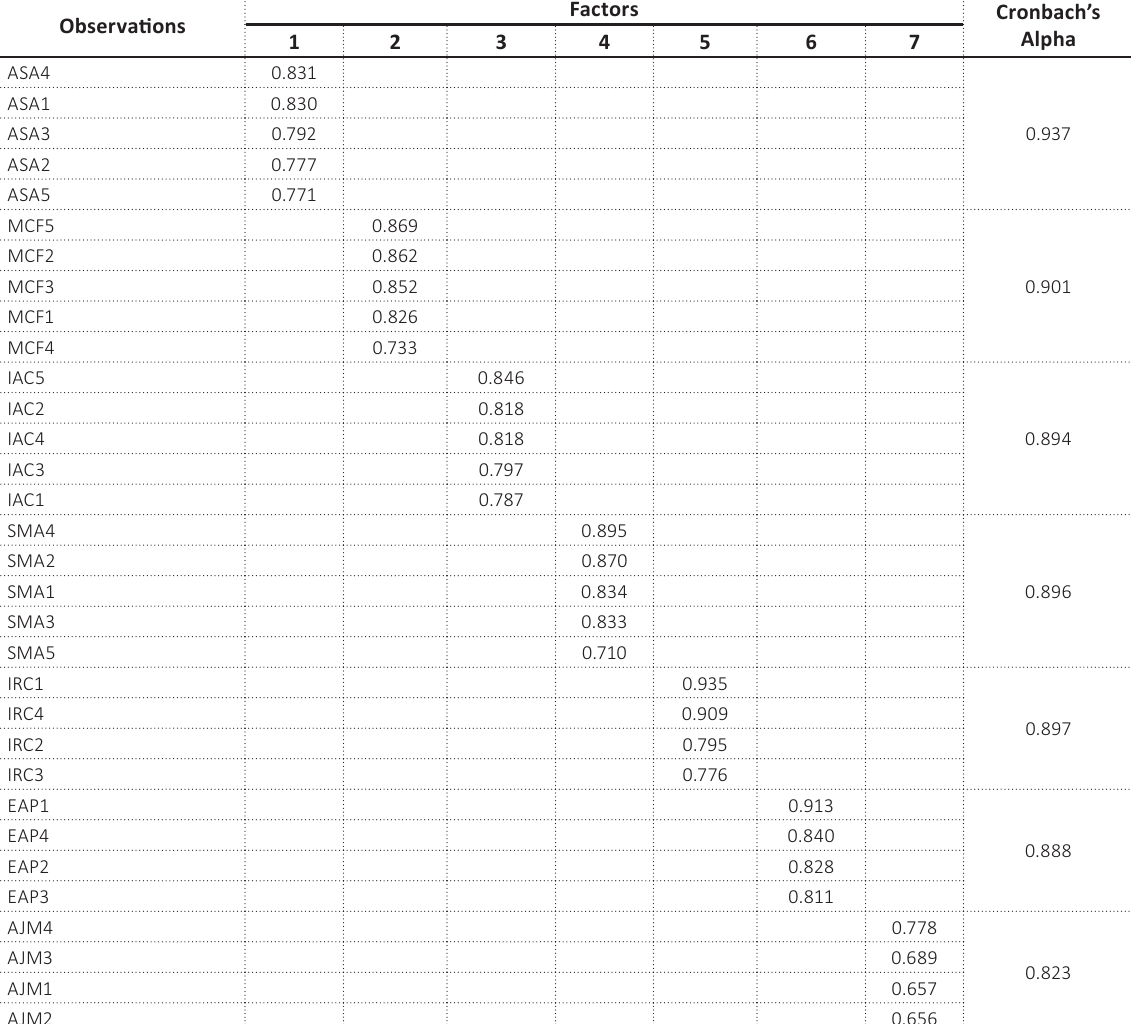
Table 2. Matrix results around the factors and CRA of observations Observations